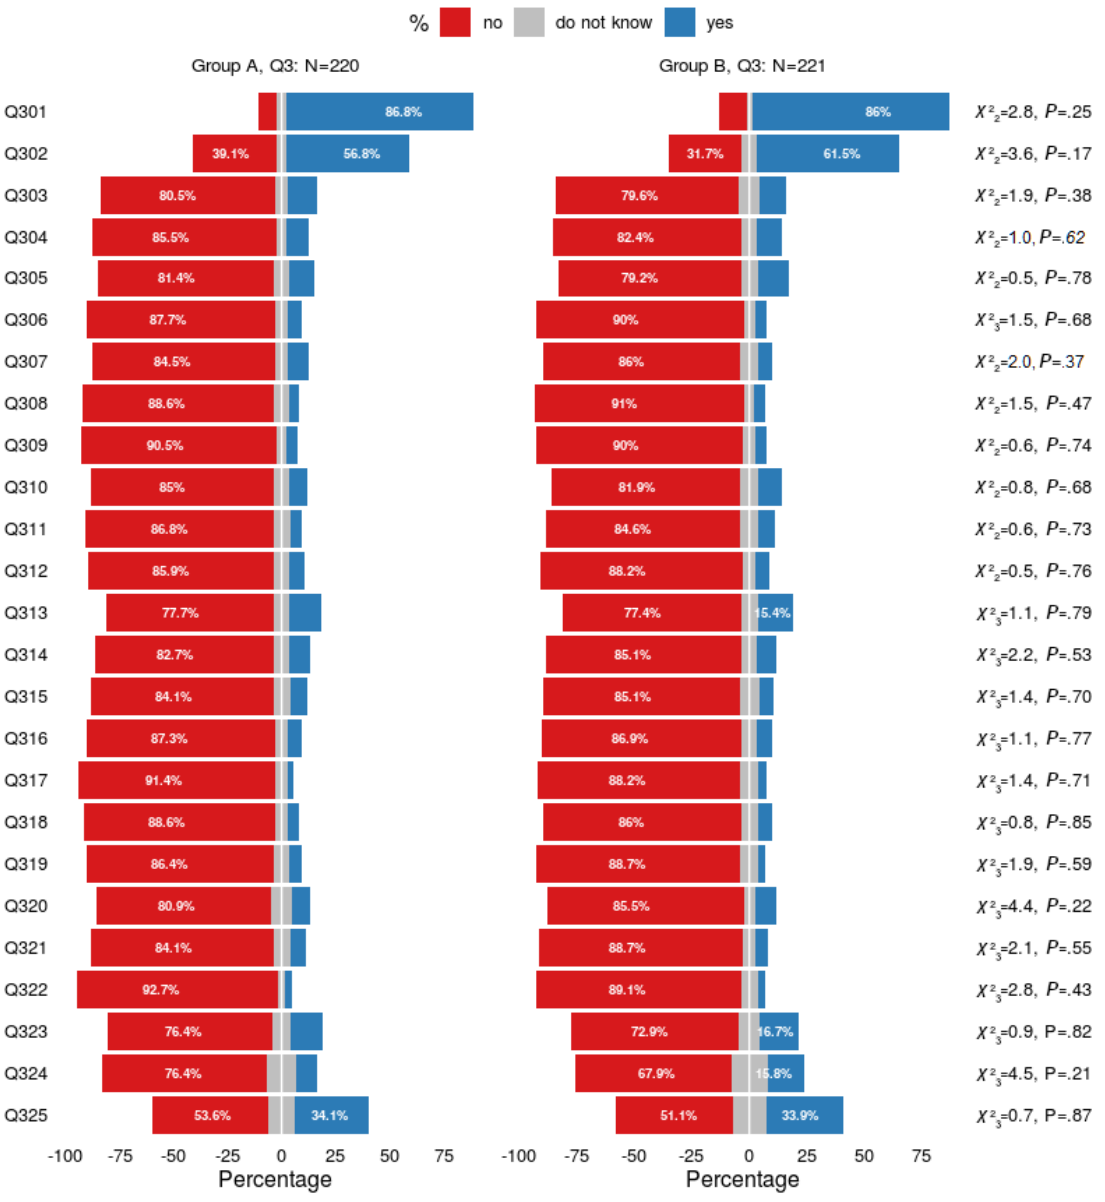
Figure 4. Graphical representation of the participants’assessments of whether the provided app descriptions contain sufficient information with respect to the nine quality principles, this time assessed using 25 key questions (Q301-Q325) and stratified by the two randomly assigned groups: group A and group B. Results of the chi-square tests are also provided. Q3: questionnaire